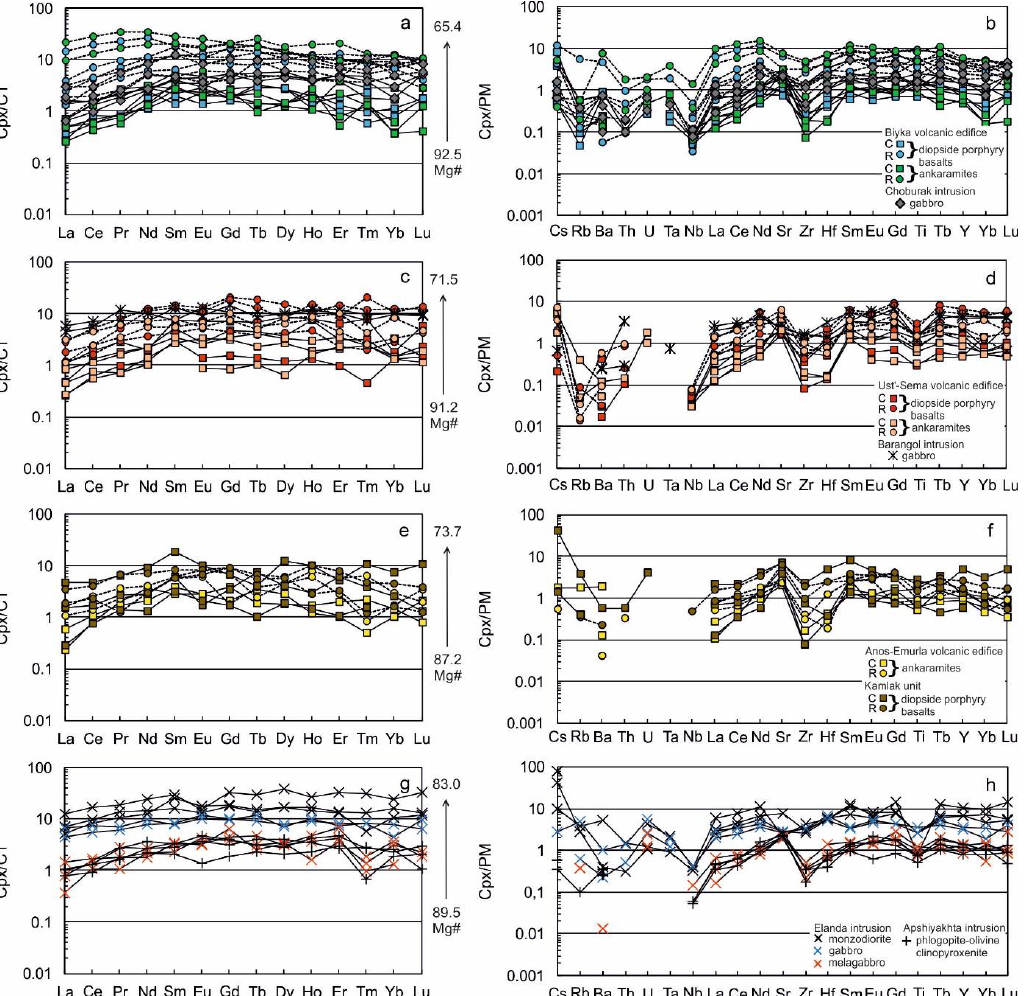
Figure 9. ( a , c , e , g ) Chondrite-normalized rare-earth element patterns [26] and ( b , d , f , h ) multiple trace element patterns normalized to the primitive mantle [32] for the clinopyroxenes from the rocks of the Ust’-Sema Formation and the Barangol Complex.